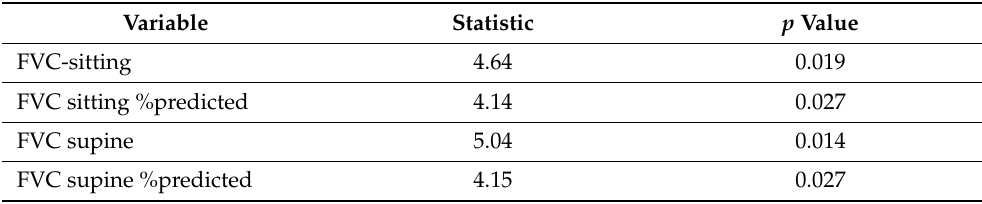
Table 6. One-way ANOVA: relationship between spirometry and thoracic scoliosis.